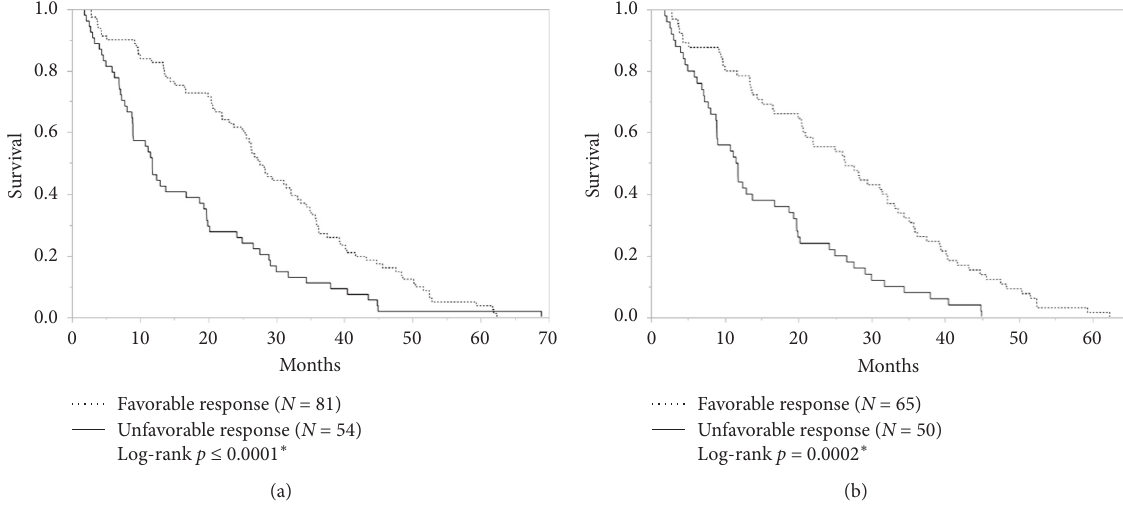
Figure 2: Overall survival for (a) complete cohort and (b) cohort censored to liver transplantation. In the complete cohort, the favorable response cohort had a longer median OS than the unfavorable response cohort (27.6 months vs. 11.8 months; p ≤ 0.0001). When liver transplantation was censored from the overall cohort, the favorable response cohort continued to have a longer median OS than the